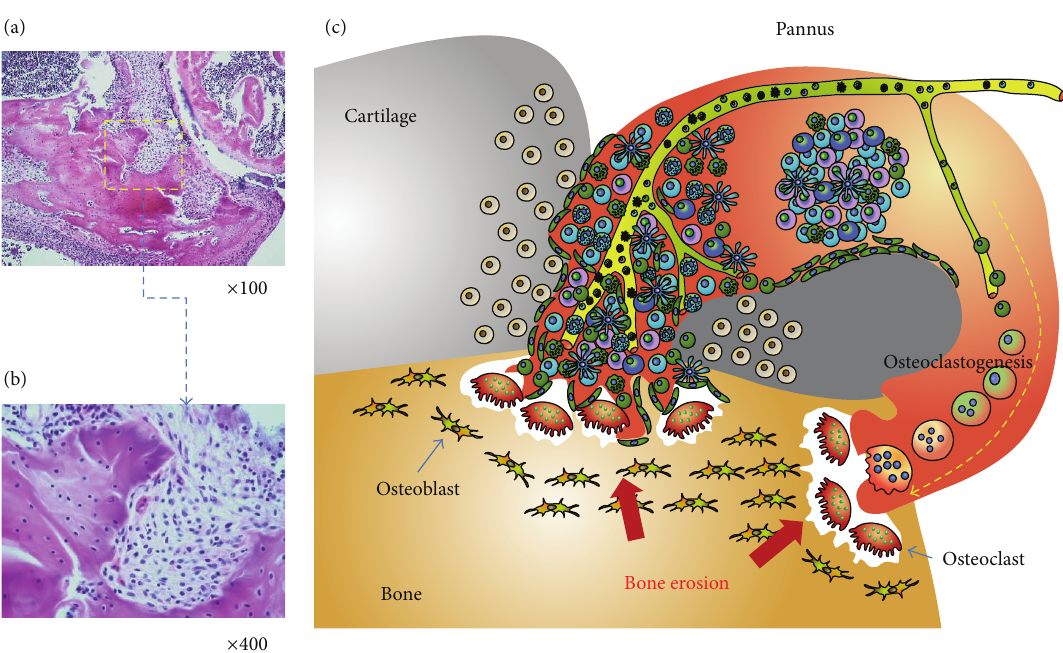
Figure2:(a)Boneisdestroyedbyaproliferativeandinvasivesynovium,whichiscalledpannus.Itoriginatesfromadjacentsynovialtissueand invades the cartilages and bones. (b) Magnified view of the pannus-bone interface. The pannus-bone interface is lined with mature